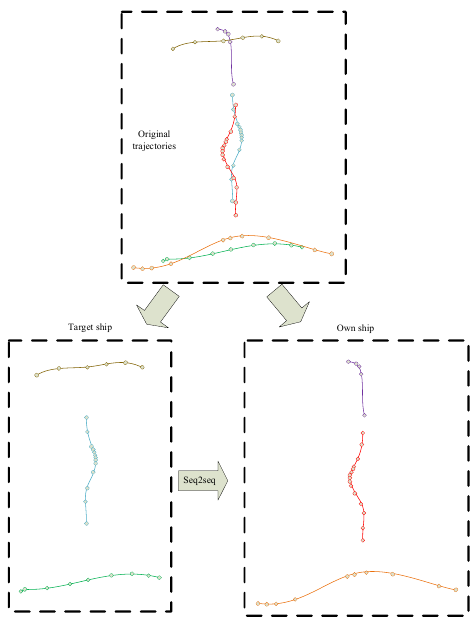
Figure 11. Conversion of the sequence-to-sequence (Seq2Seq) model.